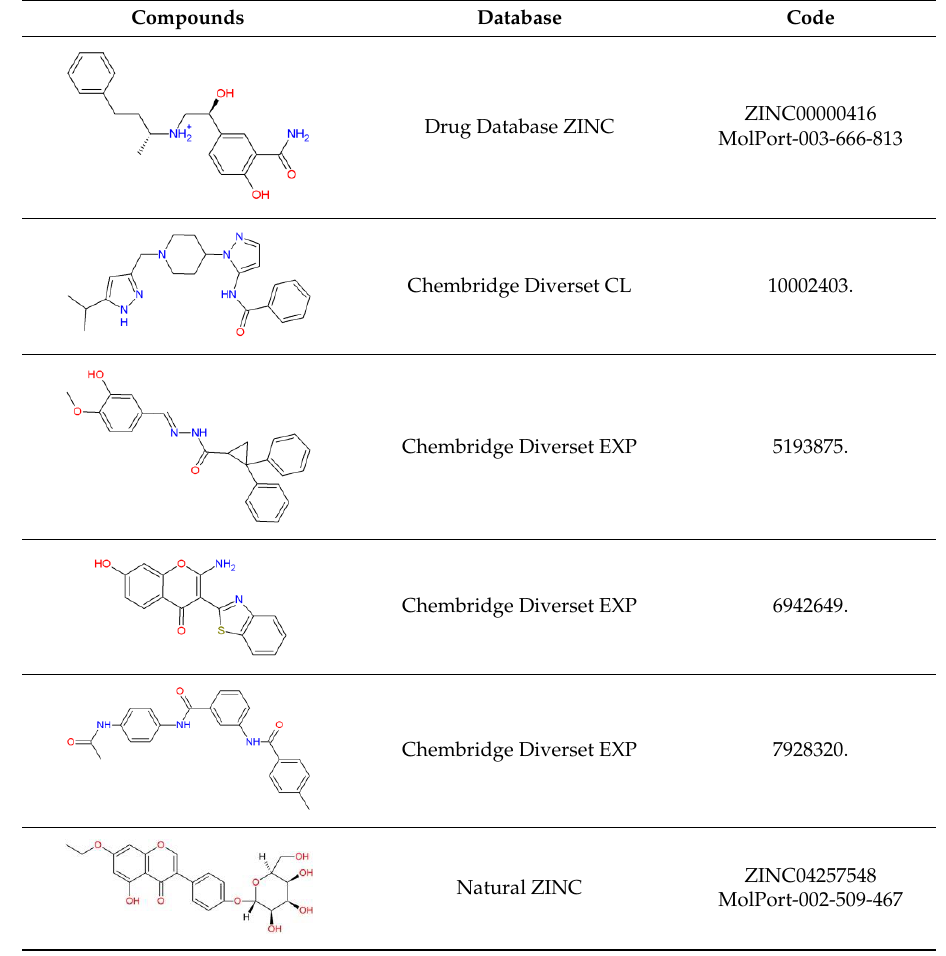
Table 6. Compounds selected by pharmacophore-based virtual screening of future purchase and biological assays (3QAK/UK-432097).